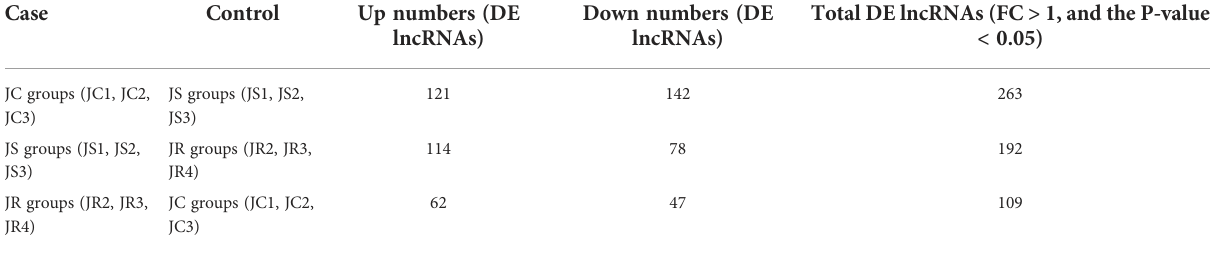
TABLE 3 Statistical information of differentially expressed